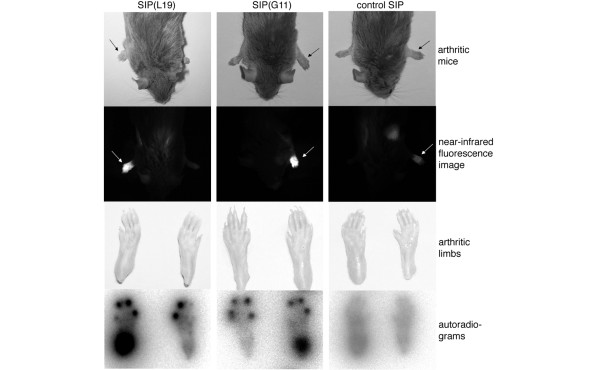
Investigation of the selective accumulation of the small immunoproteins L19 and G11 in inflamed limbs of arthritic mice. Arthritic mice were injected with SIP(L19)–Alexa750 (Molecular Probes, Leiden, The Netherlands), SIP(G11)–Alexa750 or the control antibody SIP(HyHEL10)–Alexa750. Near-infrared fluorescence imaging analysis was performed 24 hours after injection of the fluorescence-labelled antibodies. Arrows indicate grade 2 swelling in the front paws of the mice. In a similar experiment, arthritic mice were injected with 125I-labelled SIP(L19), SIP(G11) or SIP control. Uptake of radio-iodinated antibodies was analysed by phosphorimaging 24 hours after injection. The mouse injected with 125I-labelled SIP(L19) had an arthritic score of 2 in the left paw, whereas the right paw was classified as grade 1 arthritis. In the mouse injected with 125I-labelled SIP(G11) the left paw was classified as grade 1 arhritis, whereas the right paw was classified as grade 2 arthritis. In the mouse injected with 125I-labelled SIP(F16) the left paw was classified as grade 2 arthritis, whereas the right paw as grade 1 arthritis.